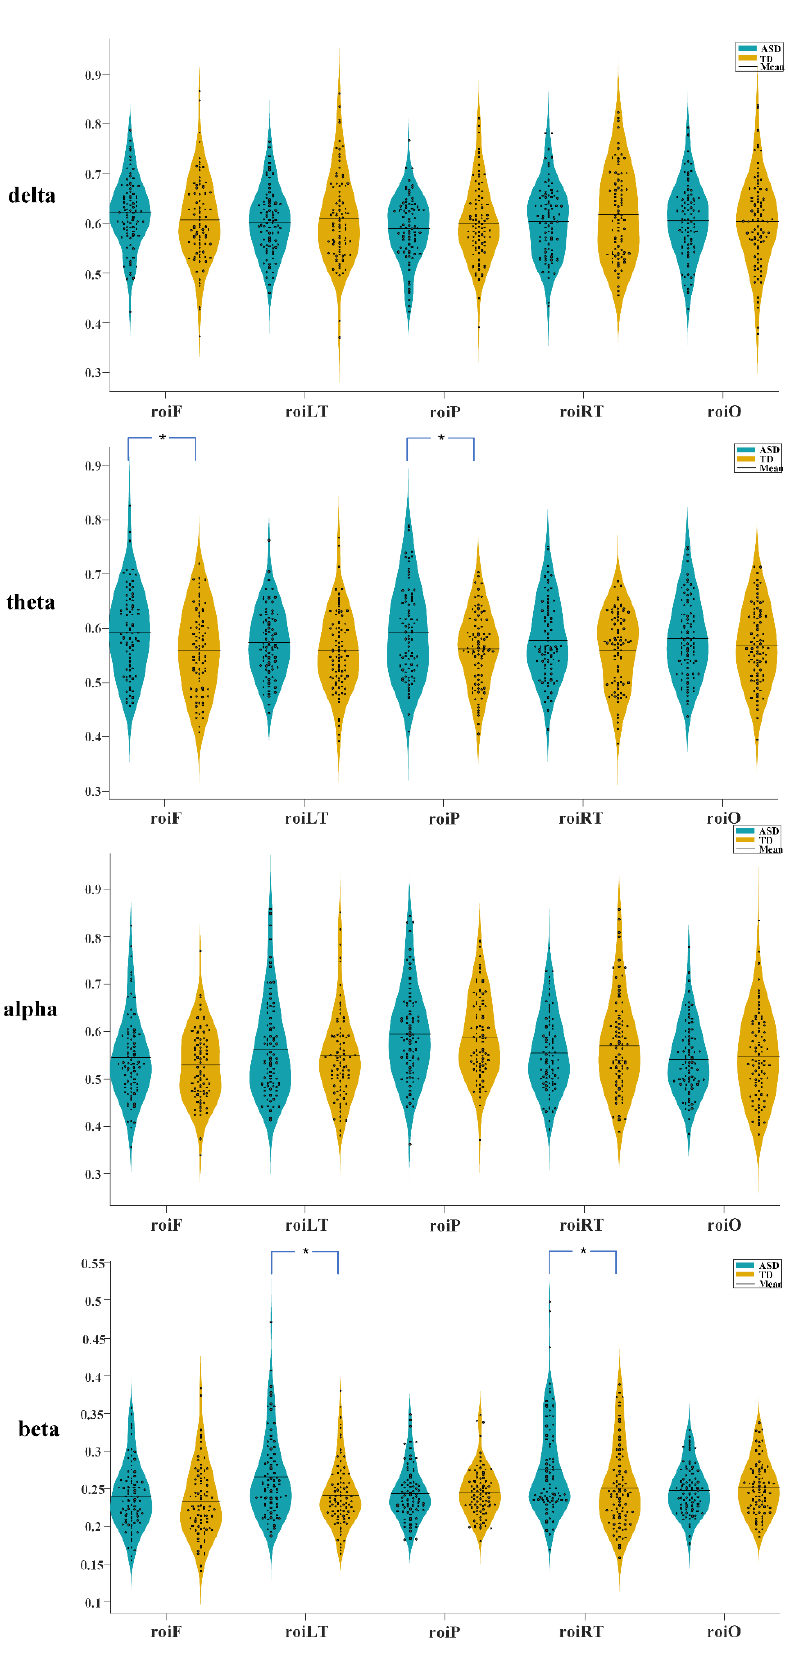
Figure 2. The functional connectivity differences in brain regions of four frequency bands between the autism spectrum disorder (ASD) and typically developing (TD) groups (* p < 0.05).